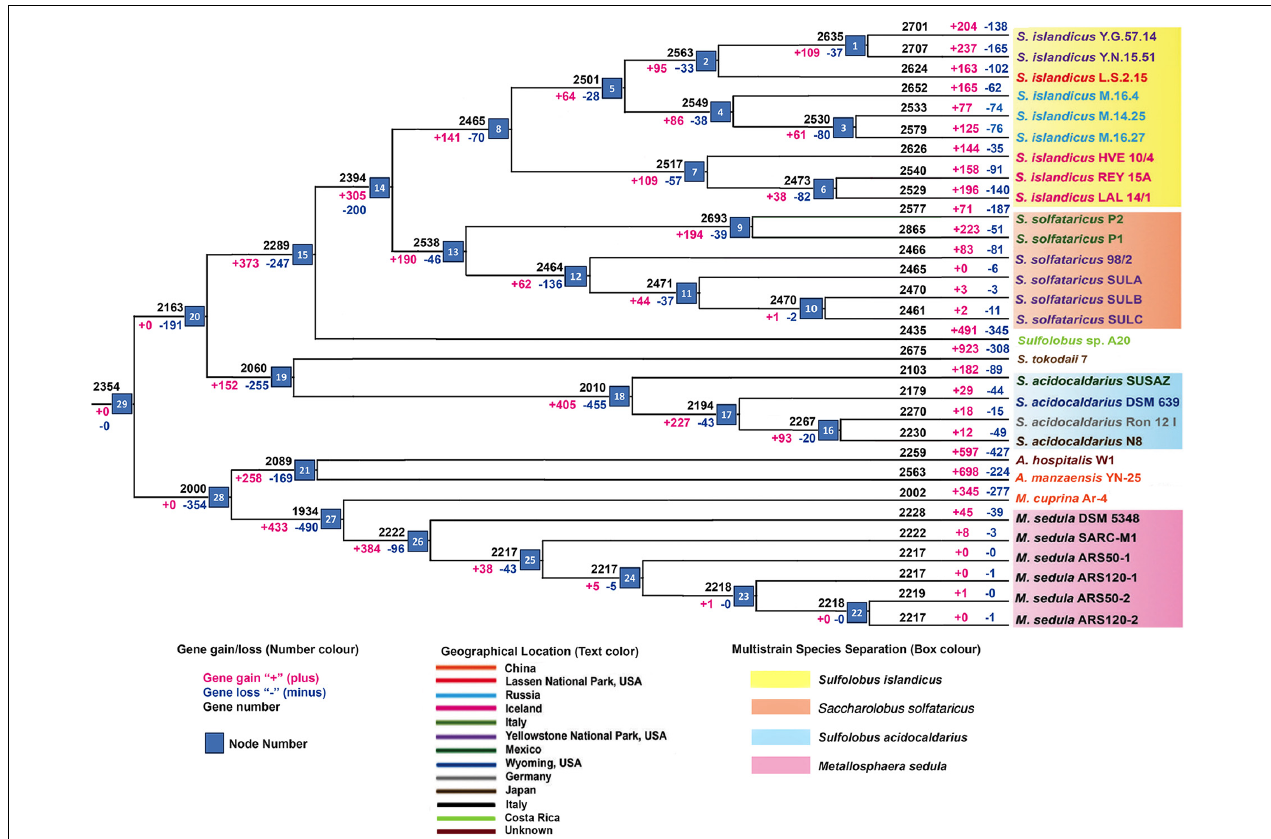
FIGURE 1 | Summary of gene gain and gene loss events by applying asymmetric Wagner parsimony in the family Sulfolobaceae , across the phylogenetic tree.